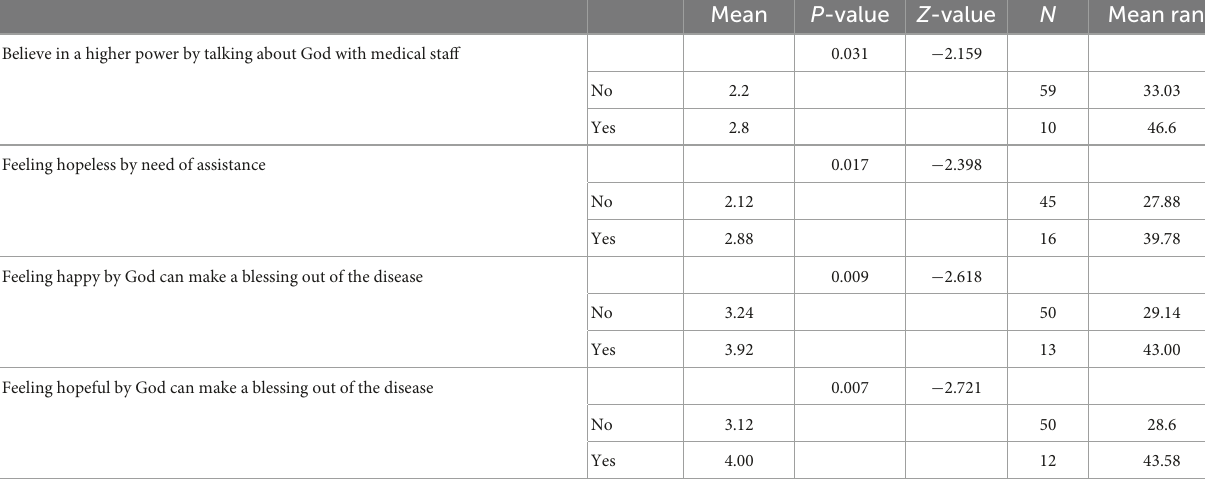
TABLE 8 The results of the Wilcoxon Rank-Sum test of the international